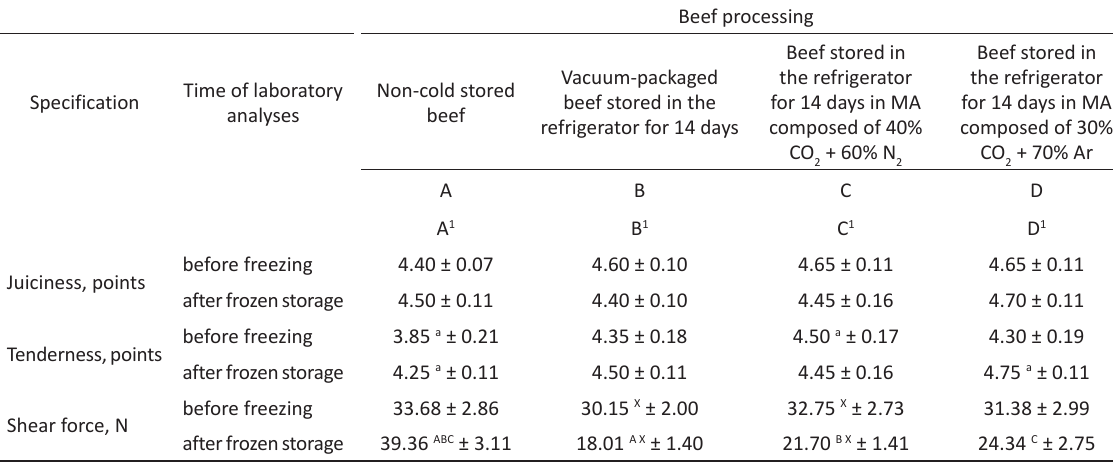
Table 5. Juiciness, tenderness and shear force values of meat